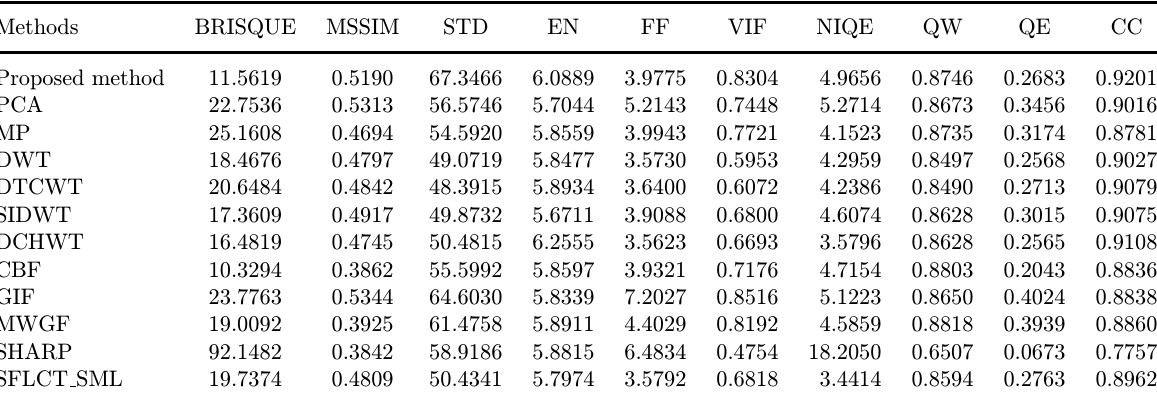
Table 2. Performance comparison for the second group of medical images.